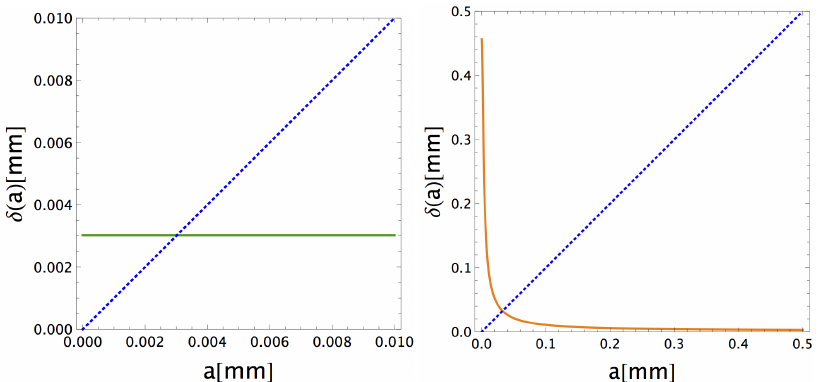
Figure 2. Graphical identification of the width limit ˜ a , satisfying Equation (34), as the intersection point between the infinite-resolution image width a (dashed lines) and the spread δ ( a ) (solid lines). The left panel represents the case z = z a , in which the object is placed in one of the two reference planes, focused on the detector, and δ is a constant. The right panel shows the case in which the object is placed midway between the two reference planes, namely z = ( z a + z b ) /2. Numerical values of the parameters are reported in the